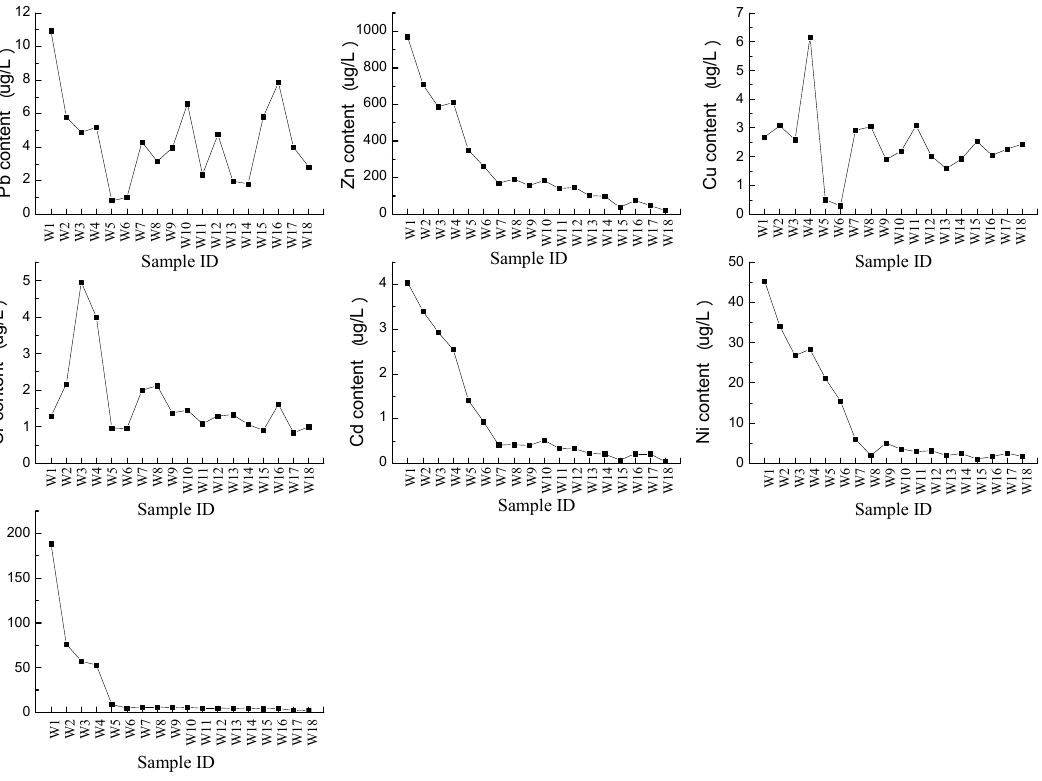
Figure 2. Heavy metal concentrations in surface water.